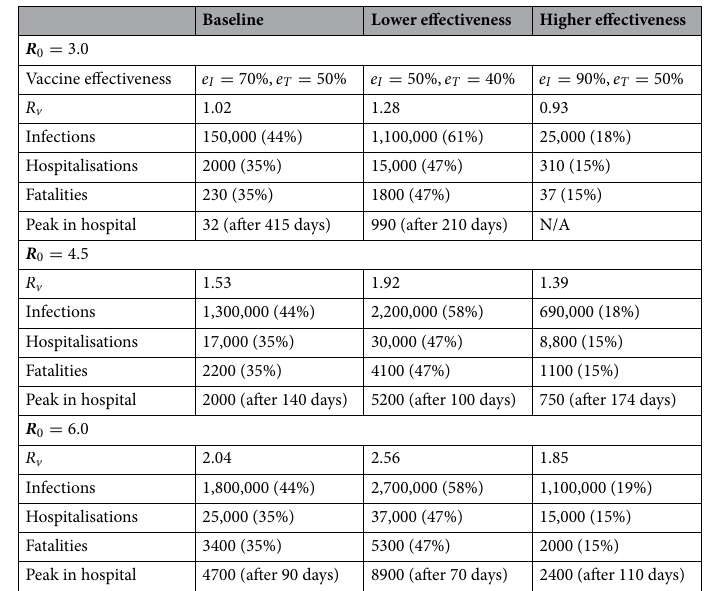
Table 3. Results from an unmitigated epidemic with R 0 = 3 (upper), R 0 = 4.5 (middle), and R 0 = 6 (lower) before vaccination and 90% vaccine coverage for over 15-year-olds. All results are given to 2 significant figures and only include the locally acquired cases, not those imported from overseas. All scenarios assume protection against severe disease given infection of e D = 80% . Numbers in parentheses are the percentage of infections/ hospitalisations/fatalities that occur in vaccinated individuals.